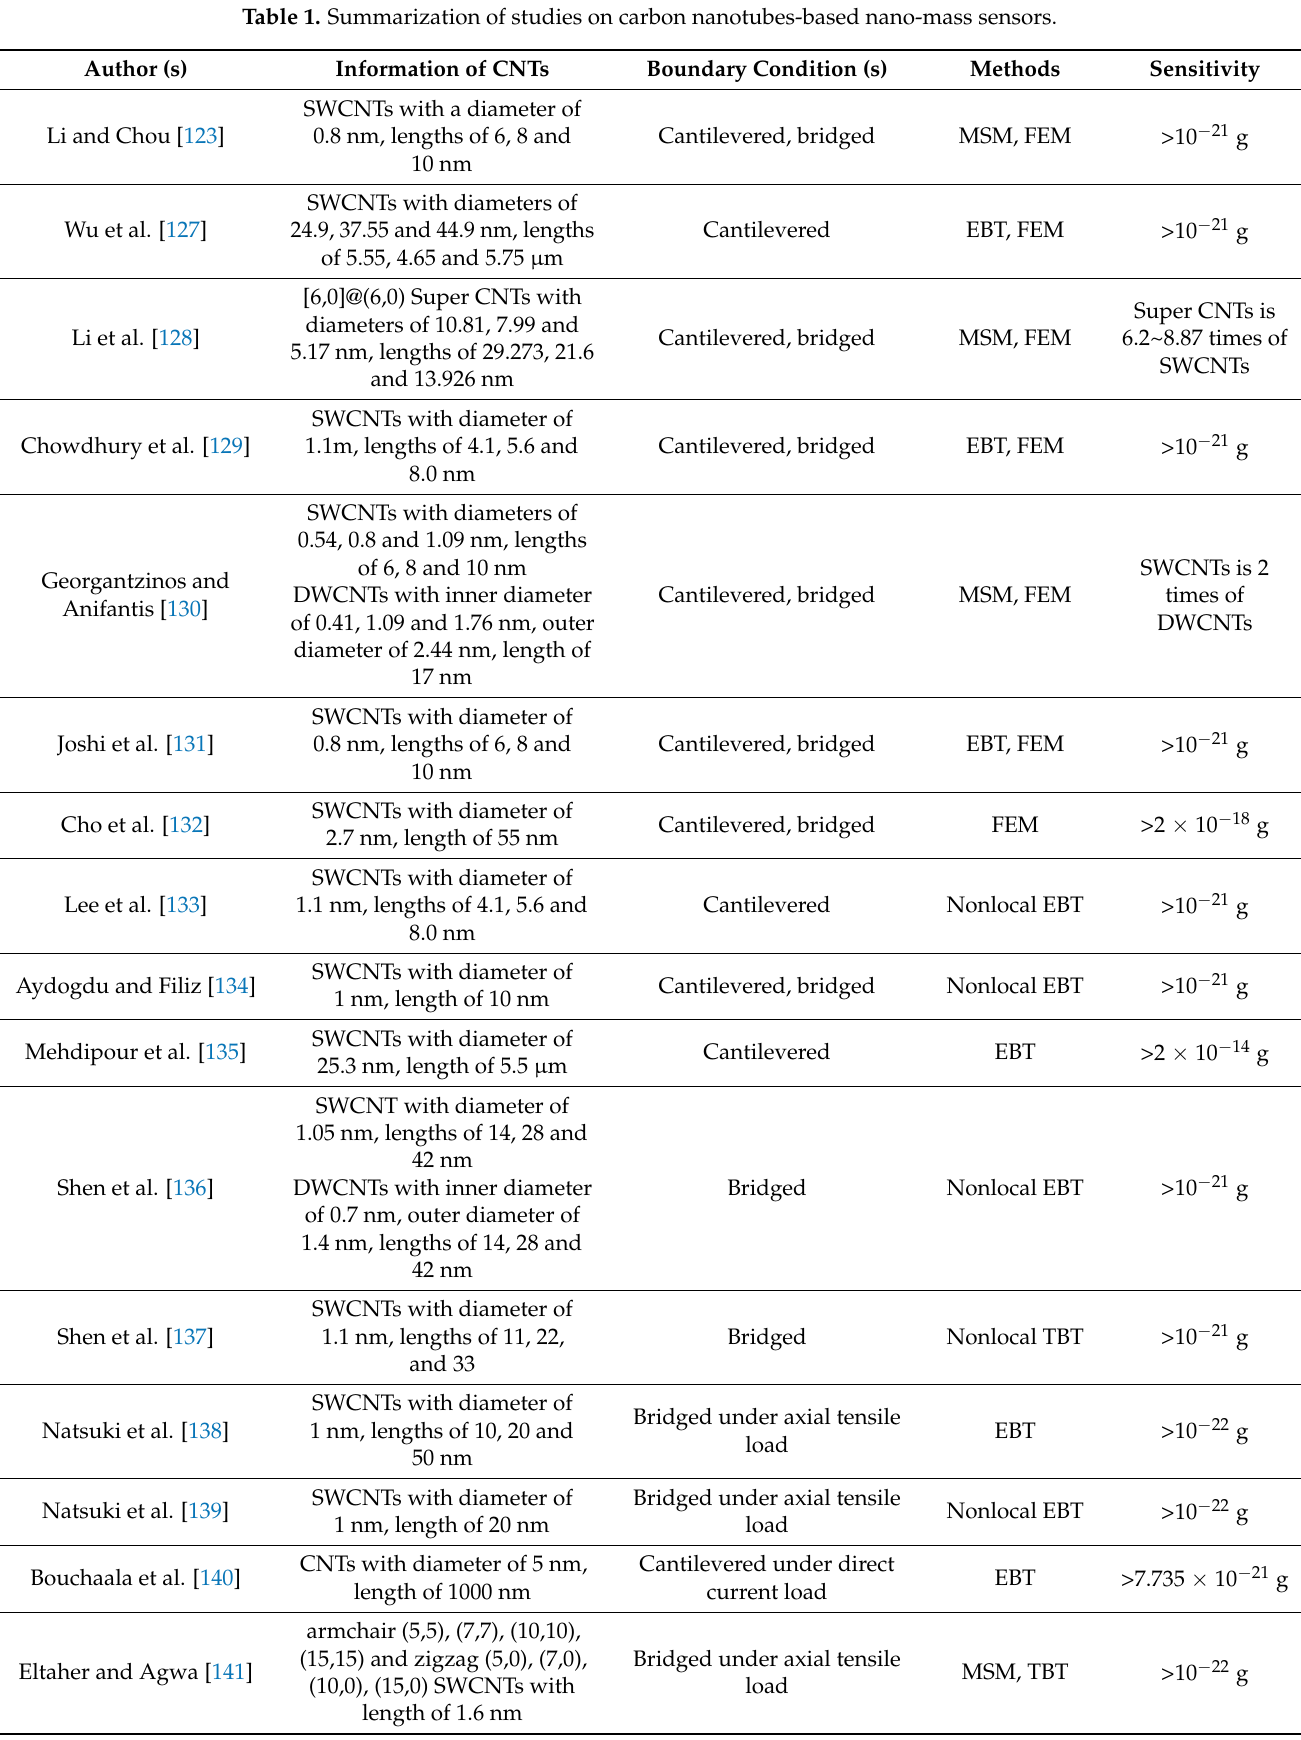
Table 1. Summarization of studies on carbon nanotubes-based nano-mass